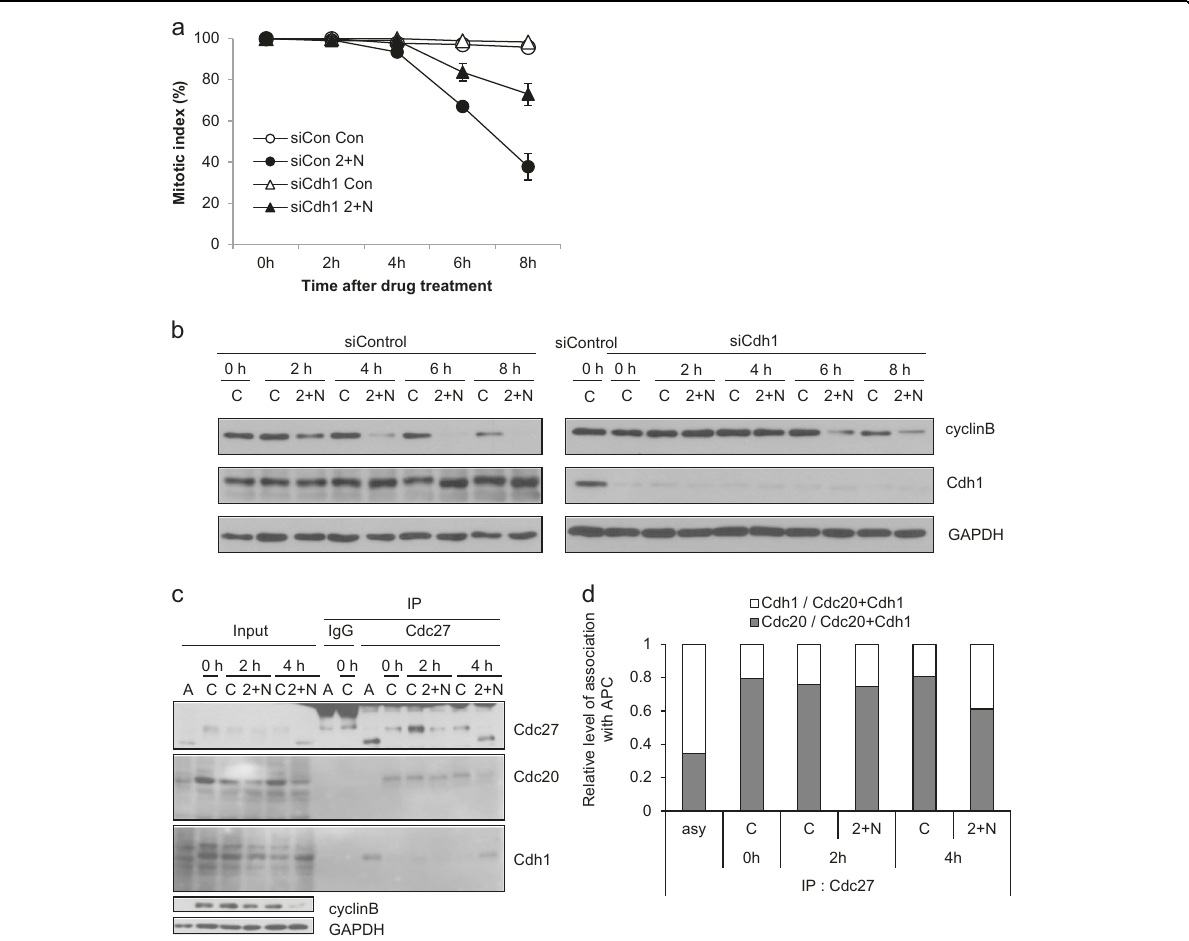
Fig. 4 APC/Cdh1, but not APC/Cdc20, is responsible for cyclin B degradation following ATP depletion. a After 20 h of Cdh1 siRNA transfection, nocodazole treatment was applied for 16 h. Mitotic cells obtained by shake off were treated with/without 2-DG and NaN 3 (2 + N). Quanti fi cation of the percentage of mitotic cells with condensed chromosome was performed by aceto-orcein staining. The results are given as the mean ± SD from three independent experiments ( n = 100). b The procedure was the same as in a . Cell lysates from the indicated times after treatment with 2-DG and NaN 3 (2 + N) were subjected to western blot analysis using antibodies for cyclin B, Cdh1 and GAPDH. c Asynchronous cells ( a ) and mitotic arrested cell lysates from the indicated times after treatment with 2-DG and NaN 3 (2 + N) were subjected to immunoprecipitation using an antibody for Cdc27 and western blot analysis using antibodies for Cdc27, Cdh1, Cdc20, cyclin B, and GAPDH. d Quanti fi cation of the relative association with APC/ C was performed by measuring the band intensity using ImageJ software after treatment with 2-DG and NaN 3 (2 + N). The results are given as the mean from fi ve independent